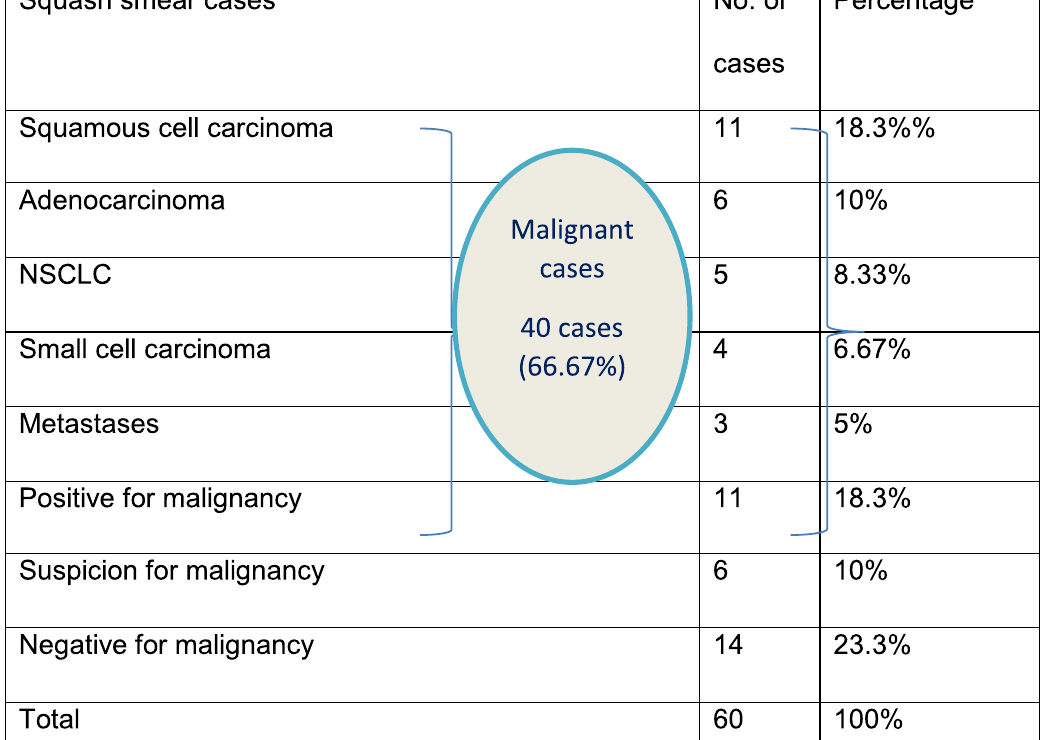
Table 1 Sub classification of cases as per squash smear cytology diagnosis ( n